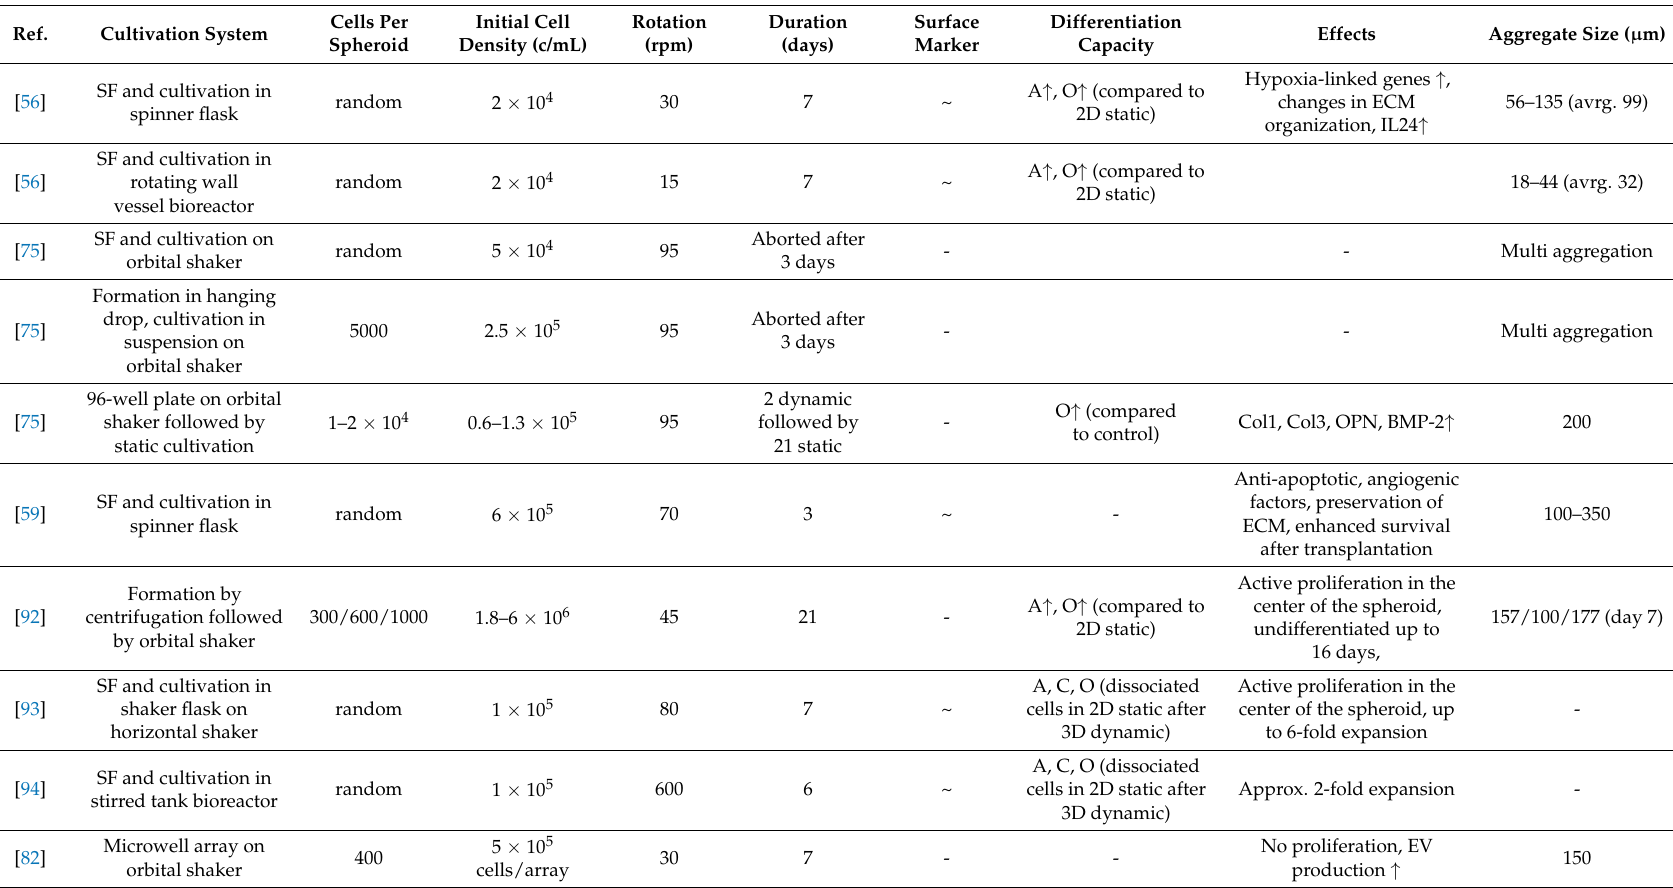
Table 1. Comparison of different studies reporting on dynamic cultivation conditions for the cultivation of MSC aggregates.